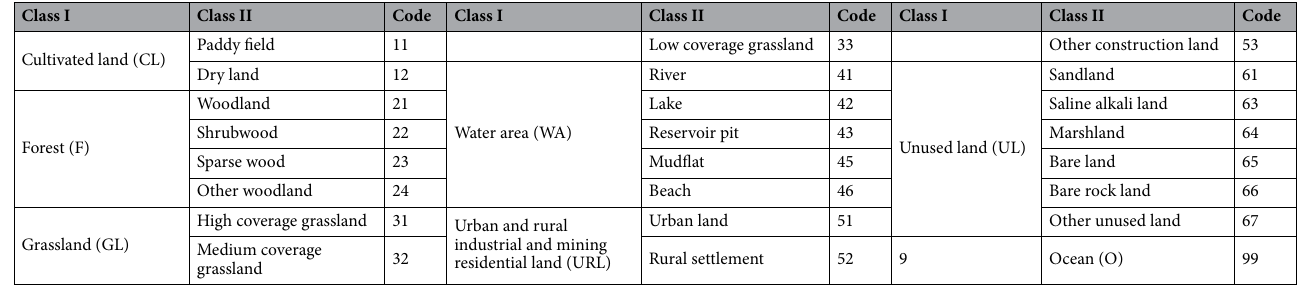
Table 1. Land use classification system in the study